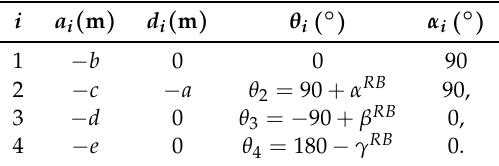
Table 3. DH parameters for the right back